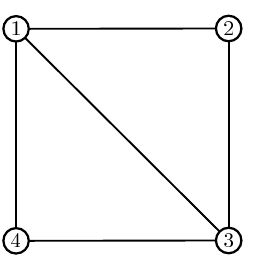
Figure 3. Internal network of the